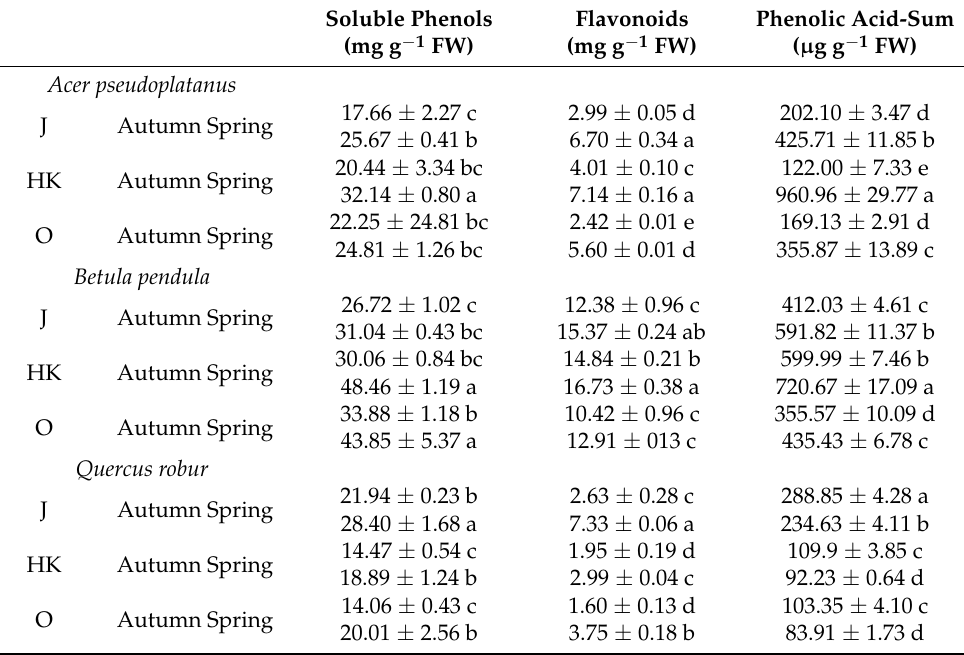
Table 1. The content of total phenols (mg g − 1 FW), flavonoids (mg g − 1 FW), and sum of phenolic acids ( µ g g − 1 FW) in bud extracts of Acer pseudoplatanus, Betula pendula, and Quercur robur . J, Jiˇc í